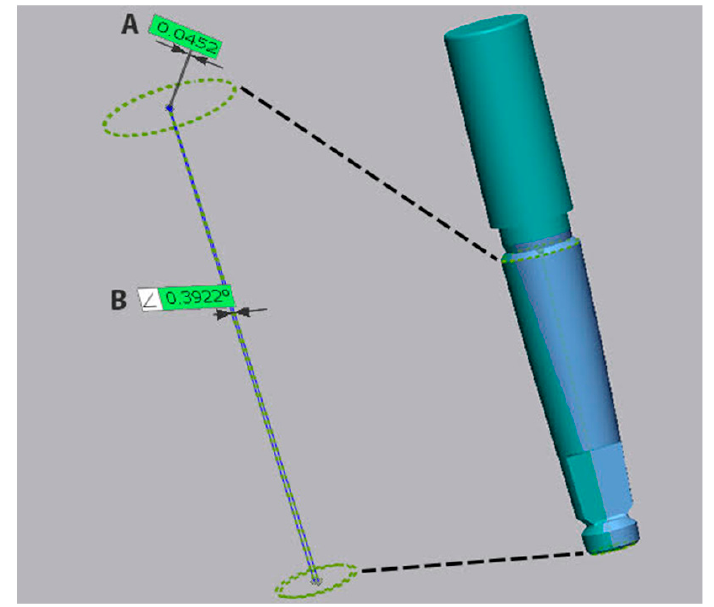
Figure 1. Angular ( A ) and coronal ( B ) measurements on one of the implants in the impression. Next, precision was determined by superimposing and comparing the test scans and measuring the coronal and angular deviation for each implant. This provides information on the reproducibility of each of the different impression techniques or systems. The full workflow is depicted in Figure